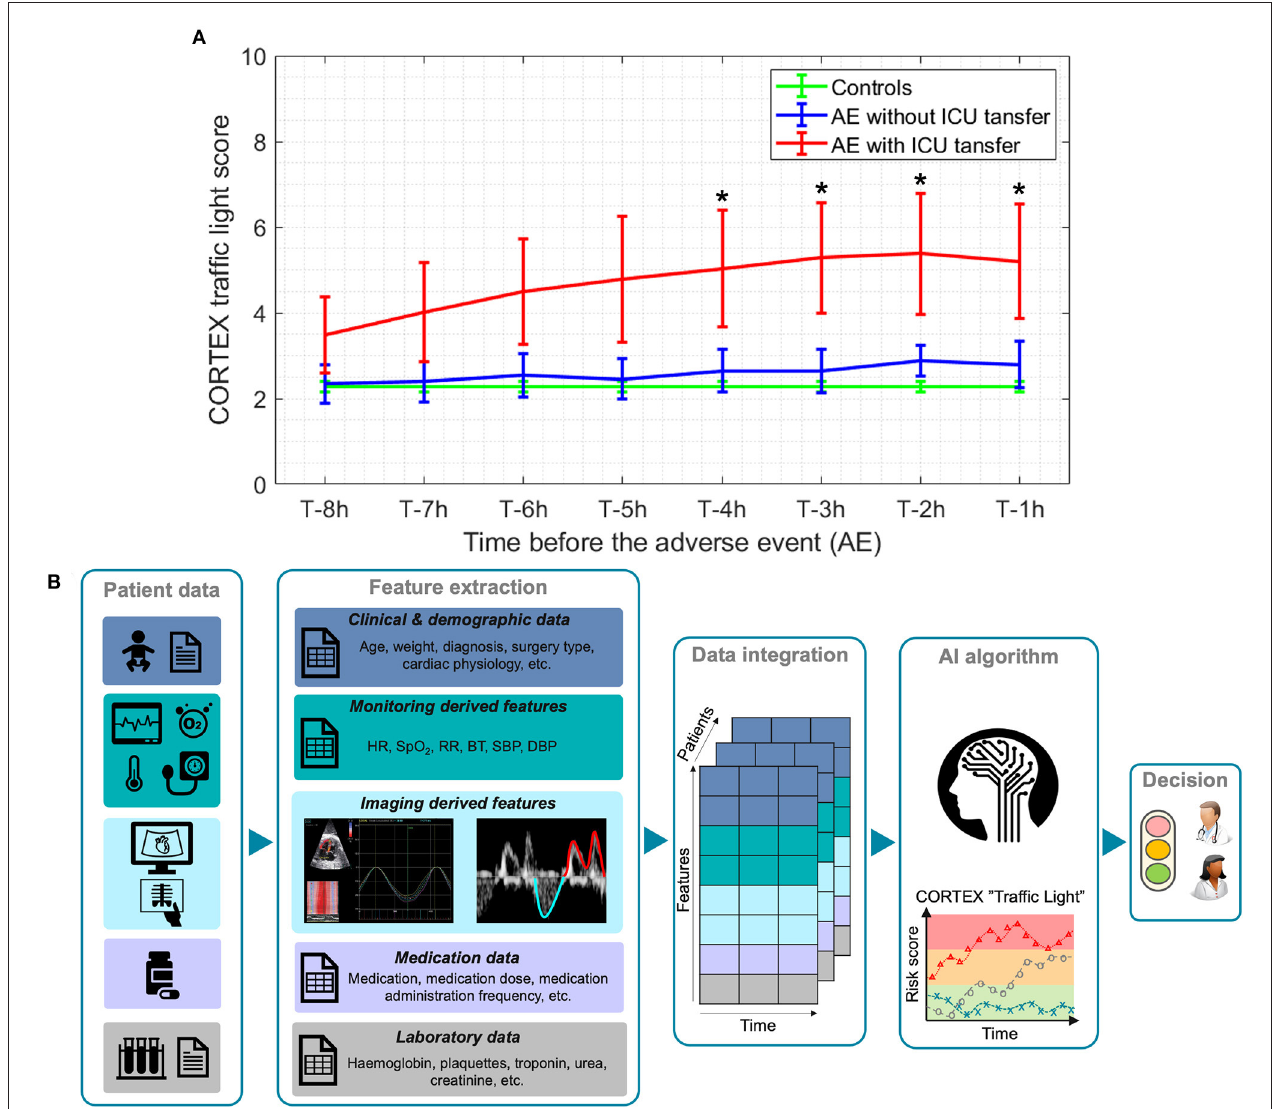
FIGURE 1 | (A) Comparison of average CORTEX “traffic light” score, from 1 to 8h before the adverse event (AE) between controls (green), patients who experience one or more AEs without an unplanned ward-to-ICU transfer (blue) and patients who experience one or more AEs followed by an unplanned ward-to-ICU transfer (red). T denotes the time when an AE occurs. Lines: group means; whiskers: + /- standard error. * Significantly different from the control group, p < 0.05. (B) The overall pipeline of CORTEX “traffic light” machine learning-based algorithm for the risk stratification of CHD pediatric